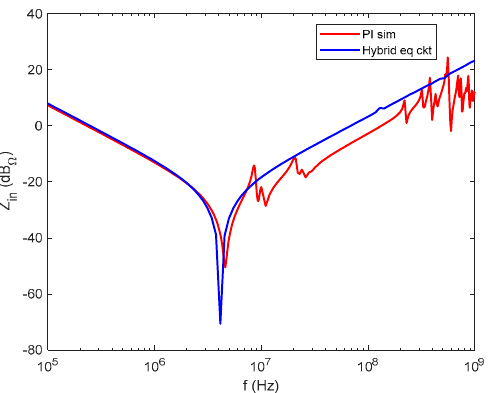
Figure 1. Frequency spectrum of the magnitude of Z in ( f ) computed by the hybrid equivalent circuit and by the PI simulator (PI sim.).